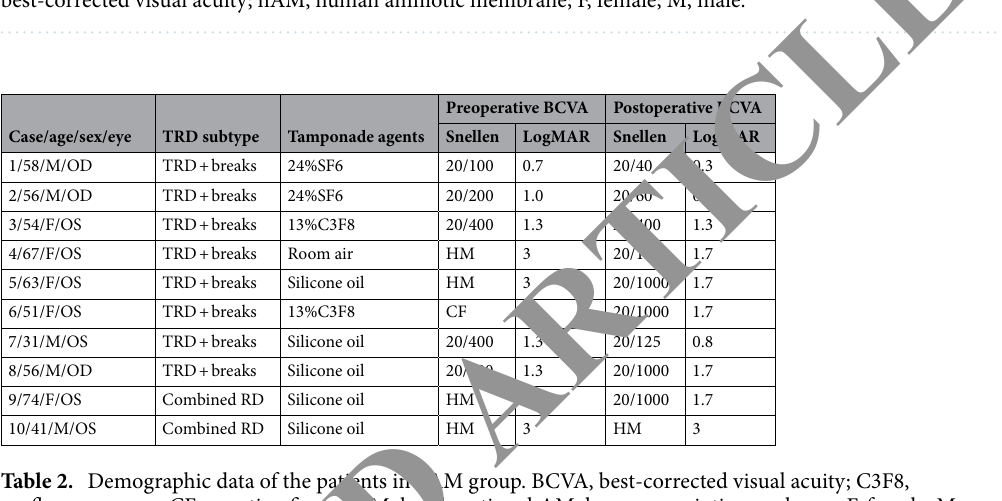
Table 2. Demographic data of the patients in hAM group. BCVA, best-corrected visual acuity; C3F8, perfluoropropane; CF, counting finger; HM, hand motion; hAM, human amniotic membrane; F, female; M,